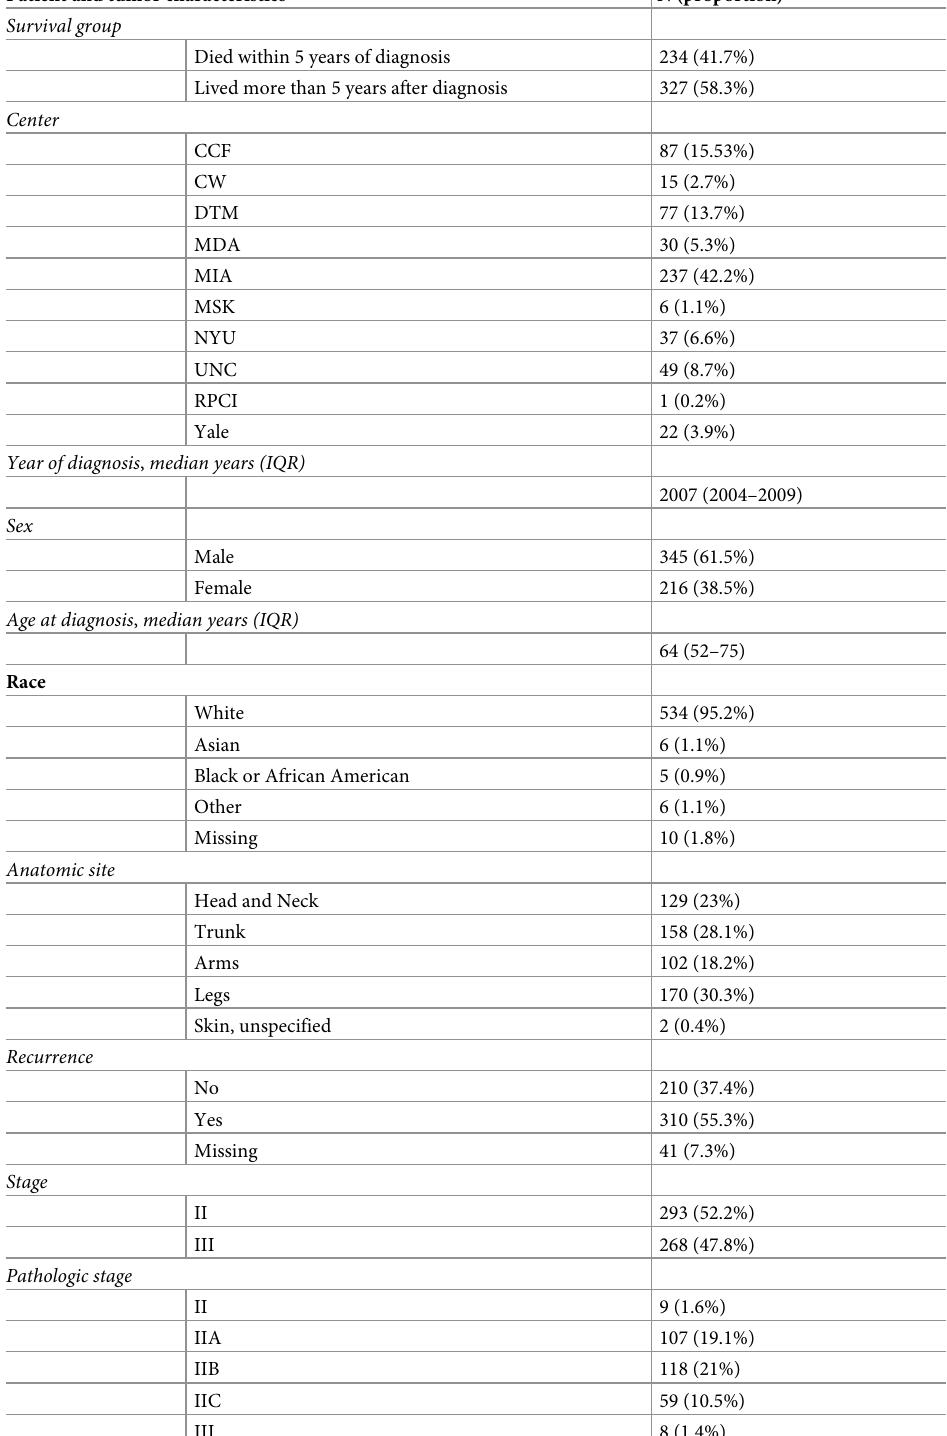
Table 1. Demographic, clinical, and detailed pathologic characteristics for patients and melanomas at the time of initial diagnosis (total, n = 561 *